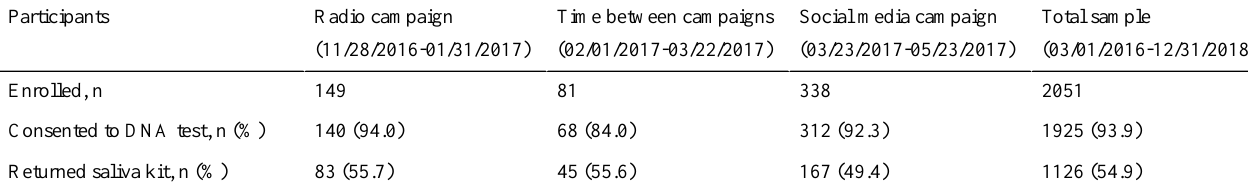
Table 2. Number of participants enrolled during and between the media campaigns.